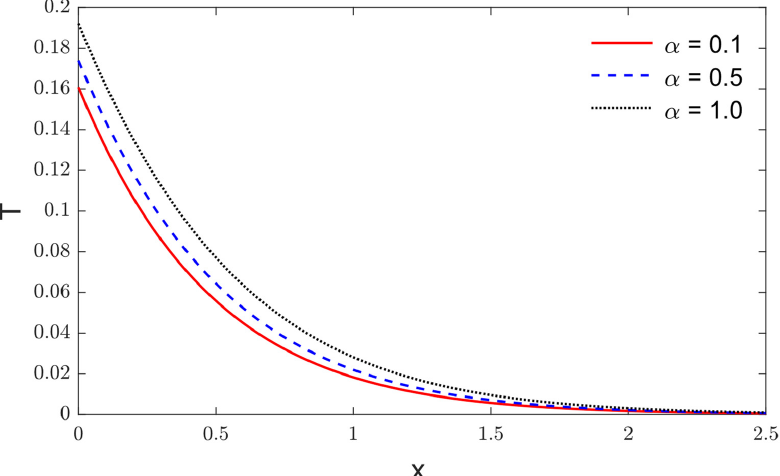
Figure 4. The impact of fractional parameter in the temperature variations along the distance x when β = 0.3 and τ o = 0.05.